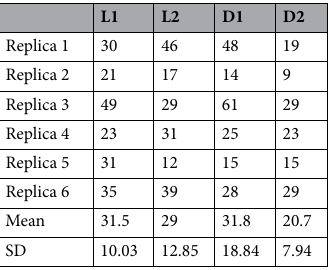
Table 1. Number of marked ants in each work shift of each